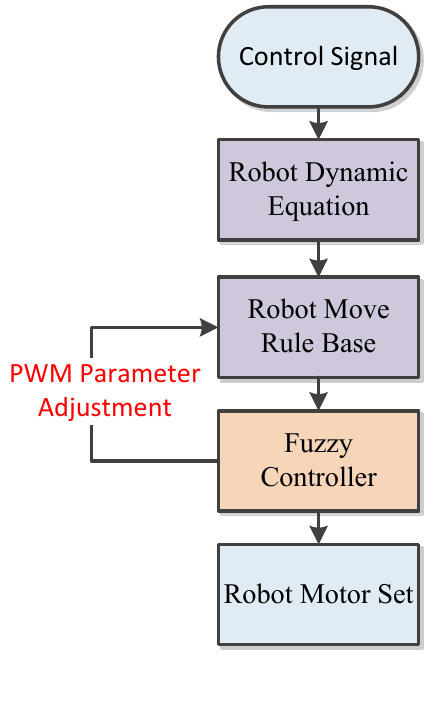
Figure 4. Proposed system